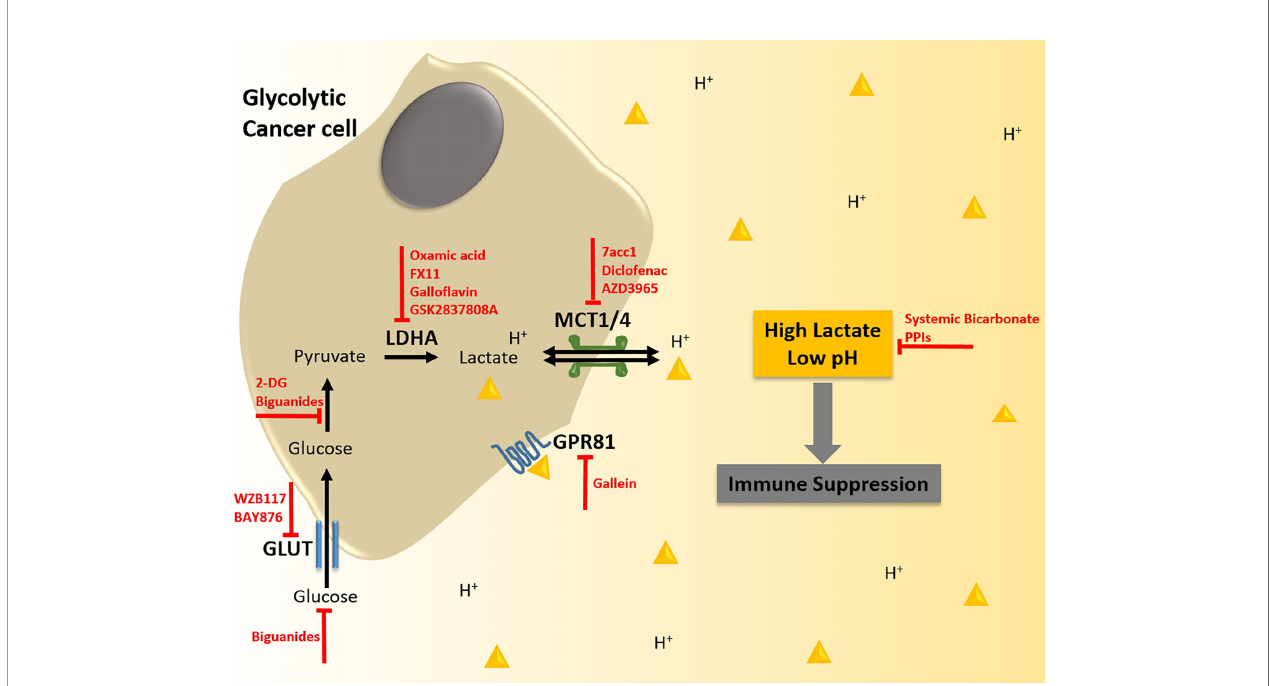
FIGURE 2 | Strategies to target lactate biogenesis and acidosis to enhance immunotherapy response in triple negative breast cancer (TNBC). TNBC tumor cells display enhanced rates of glycolysis. This metabolic phenotype is supported by the increased expression of glucose transporters (GLUTs) that import glucose into the cell, and of lactate dehydrogenase A (LDHA) that converts the glycolytic intermediate pyruvate into lactate. The augmented production of lactate in TNBC tumors is also associated with higher expression of monocarboxylate transporters (MCTs), which shuttle lactate coupled to protons (H + ) out of the tumor cell resulting in excessive levels of lactic acid in the tumor microenvironment (TME) and reduced pH. Lactate acidosis in the TME creates an immunosuppressive milieu, which can antagonize the ef fi cacy of immunotherapy. Thus, anti-metabolic strategies could alleviate lactic acid-induced immunosuppression and potentiate immunotherapy such as Adoptive T cell therapy (ACT), Chimeric Antigen Receptor T cell (CAR-T) therapy, and Immune Checkpoint Blockade (ICB), thereby synergistically inhibiting tumorigenesis. Potential strategies to abrogate lactate biogenesis and acidosis include speci fi c targeting of GLUTs, LDHA, MCTs, and the lactate-receptor GPR81 with small molecule inhibitors, inhibition of glucose-pyruvate conversion, systemically lowering the availability of glucose by treatment with biguanides, and buffering the intra-tumoral pH with bicarbonate therapy or proton pump inhibitors